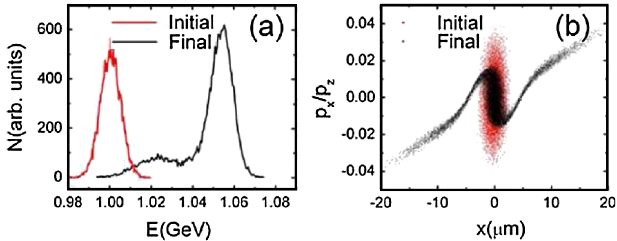
FIG. 4. 2D PIC scaled simulation results of an electron bunch ¼ 1 : 4 , r ¼ 5 (cid:2) m , (cid:5) ¼ 9 fs , and N ¼ acceleration for a L L b 0 ¼ 7 : 5 (cid:7) 10 18 cm (cid:1) 3 ; (a) the 8 : 8 (cid:7) 10 7 at the plasma density n e electron energy spectrum and (b) the transverse phase space plot Þ . The red curve shows the initial energy spectrum and ð x; p =p x z the red dots plot the initial transverse phase space distribution.